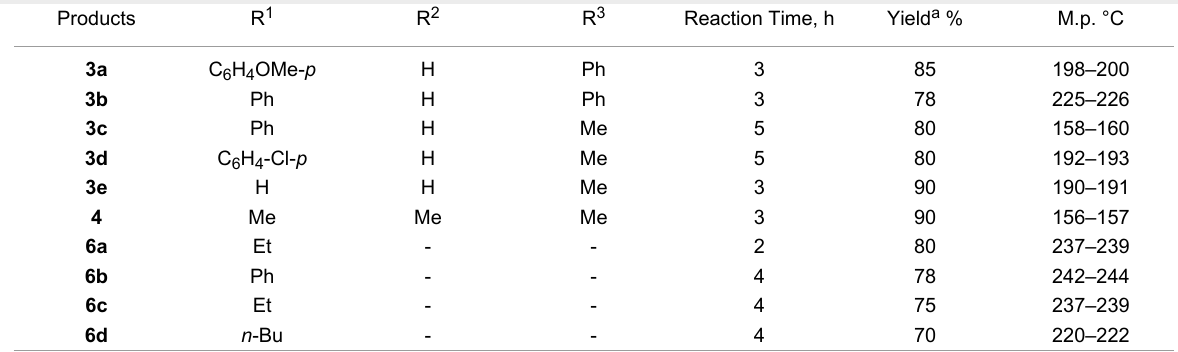
Table 1: Characteristics for Pyrimido [4,5- c ][1,2]diazepines 3 & 4 and pyrazolo [3,4- d ]pyrimidines 6 .